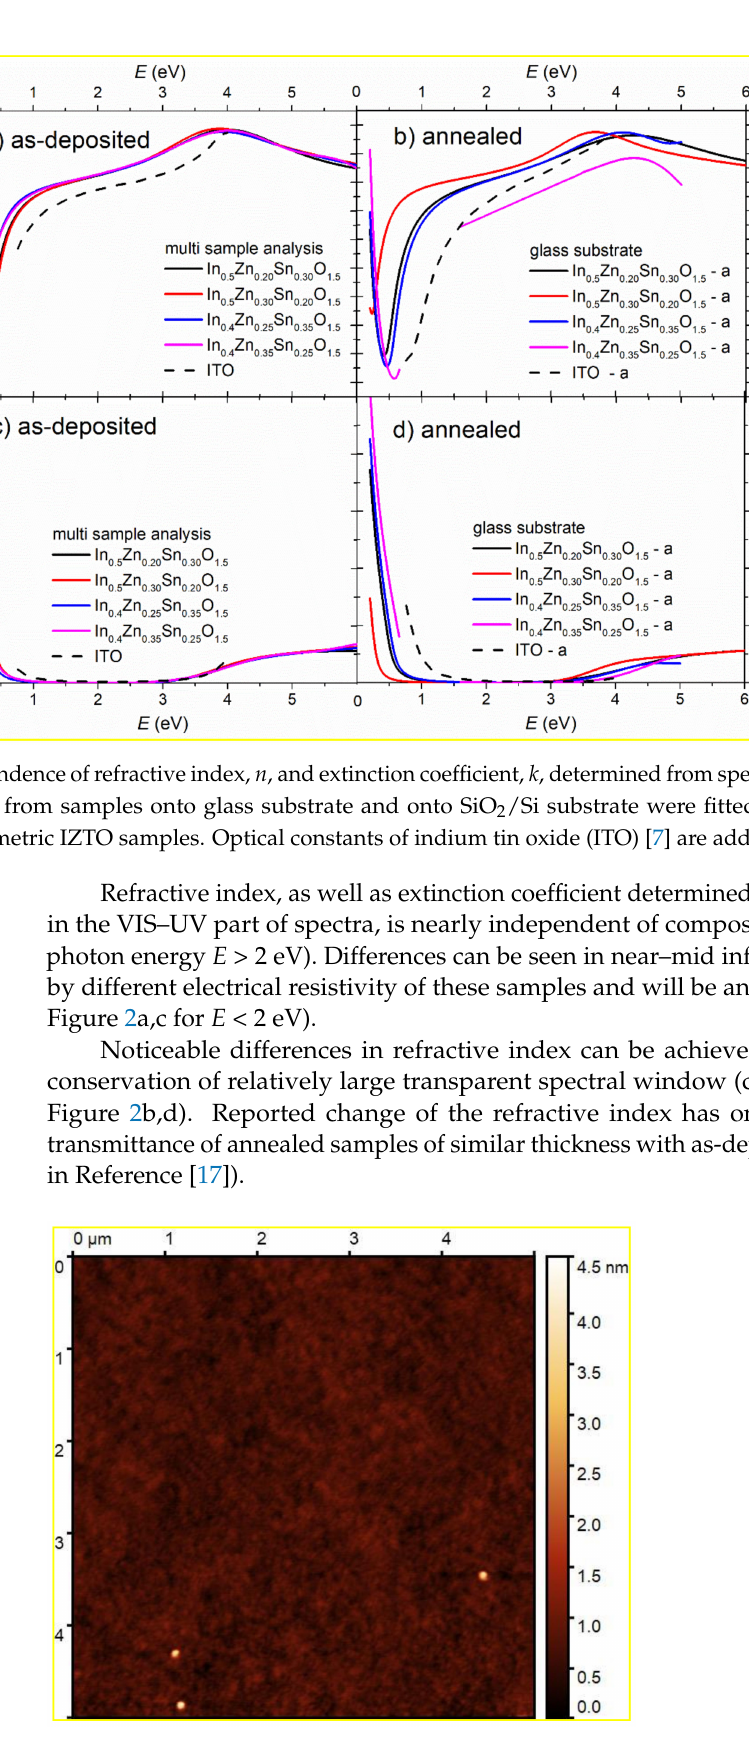
Figure 3. AFM scan of as-deposited In 0.5 Zn 0.30 Sn 0.20 O 1.5 (IZTO25 Zn-rich)